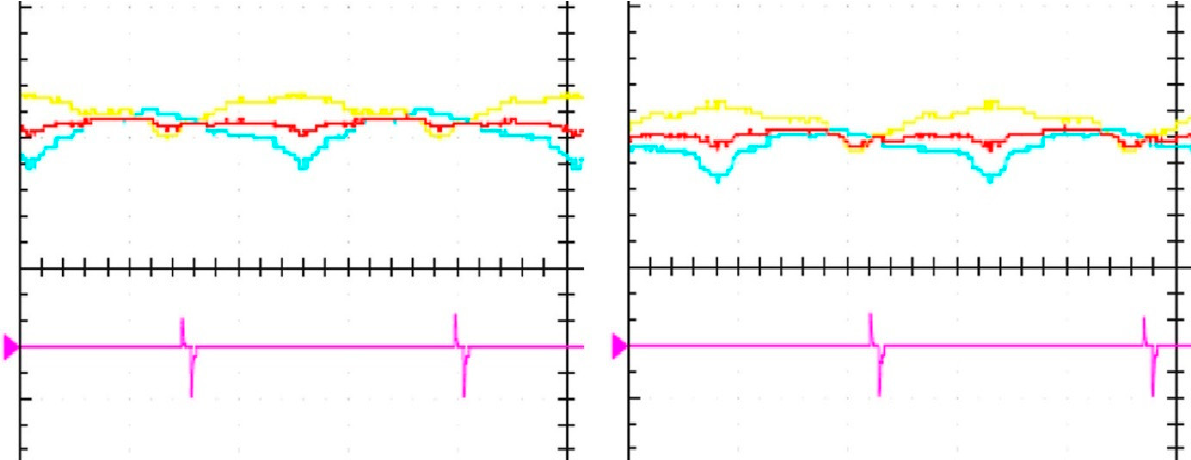
Figure 15. Signals from a pair of sensors with shift by π : on the left—for deflection { Δ v 1 = (+)0.04; Δ v 2 = (+)0.02; Δ v 3 = 0.00}; on the right—for deflection { Δ v 1 = (+)0.01; Δ v 2 = ( − )0.015; Δ v 3 = ( − )0.005}; yellow—signal of sensor CH1, blue—signal of sensor CH2, red—averaged signal (CH1 + CH2)/2, purple—signal of rotation angle marker, blue arrow—zero value of signals (CH1 = 0, CH2 = 0, (CH1 + CH2)/2 = 0). CH1 = CH2 = 1.00 V/DIV; CH1 + CH2 = 2.00 V/DIV.